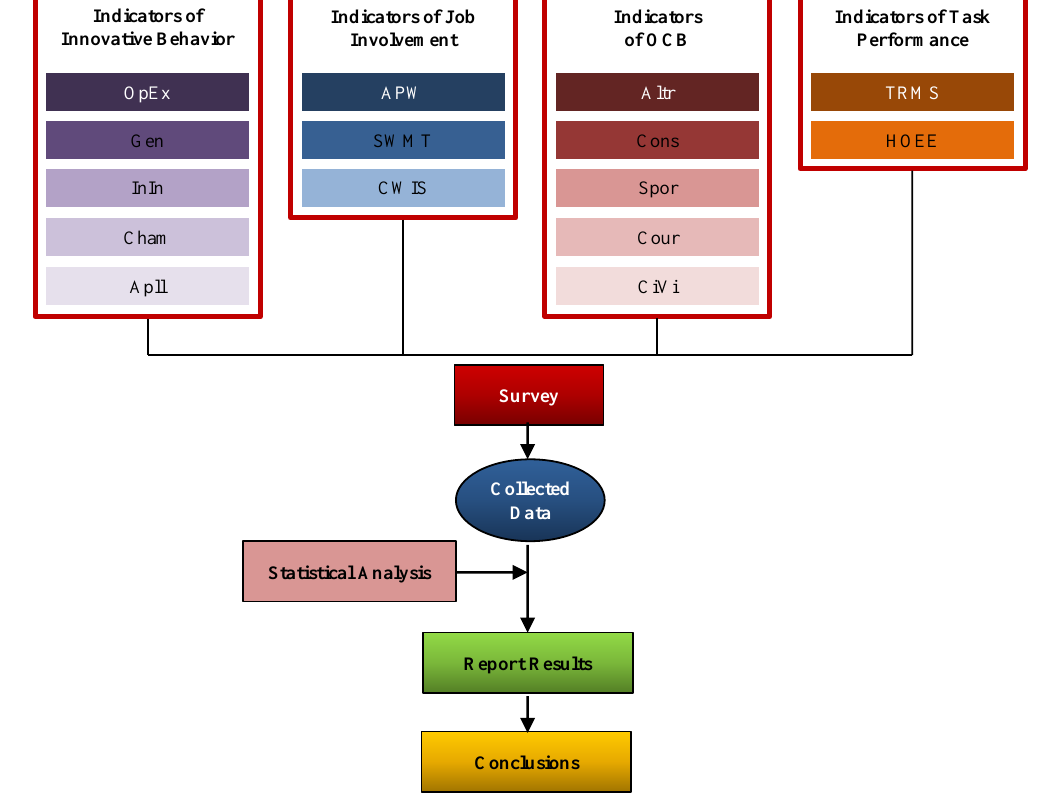
Figure 1. Flowchart of Research